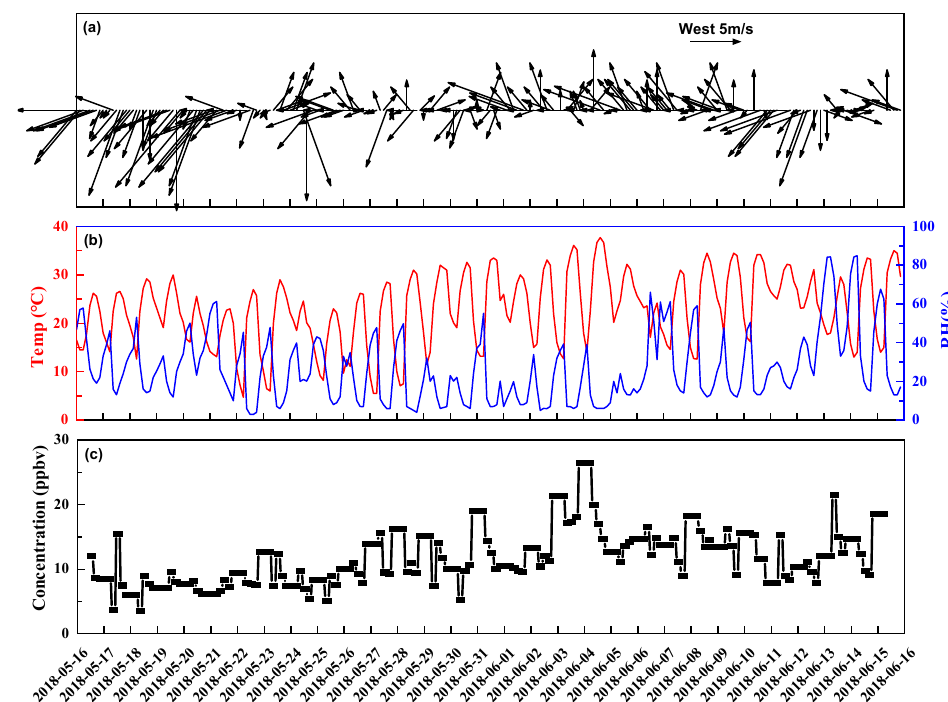
Figure 2. Time series of averaged data for ( a ) wind speed and direction (every 3 h), ( b ) temperature and relative humidity (every 3 h), and ( c ) total carbonyl concentration during the sampling period (every 4 h from 9:00 − 21:00, and 12 h from 21:00 − 9:00 the next day). The average concentrations (±standard deviation) of those carbonyls measured at four time periods are summarized in Table 1. The average concentration of total carbonyls during the sampling period was 11.79 ± 4.03 ppbv, ranging from 3.70 to 26.44 ppbv. The three most abundant carbonyls were formaldehyde (6.08 ± 2.37 ppbv), acetaldehyde (1.68 ± 0.78 ppbv), and acetone (2.52 ± 0.68 ppbv), which accounted for 51.6%, 14.2%, and 21.4%,